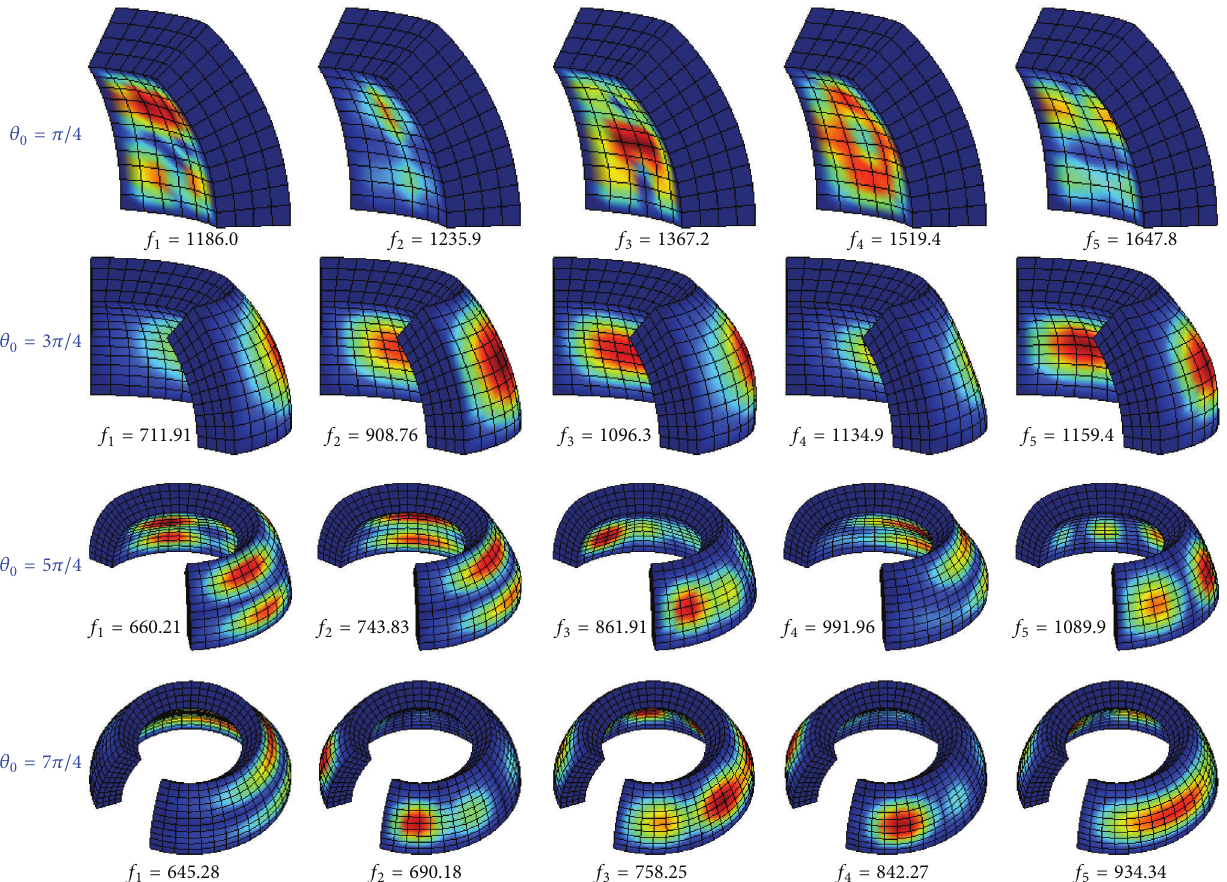
Figure 9: Mode shapes of an orthotropic spherical shell with CCCC boundary conditions and various circumferential